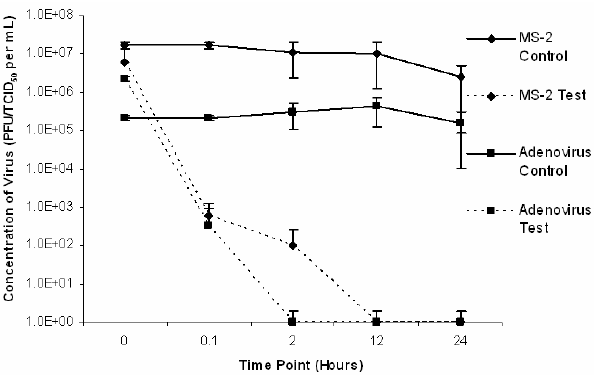
Figure 1: Average adenovirus type 5 and MS2 inactivation in sludge matrices (compost, raw and previously limed) lime stabilized at room temperature (22 ± 5°C).